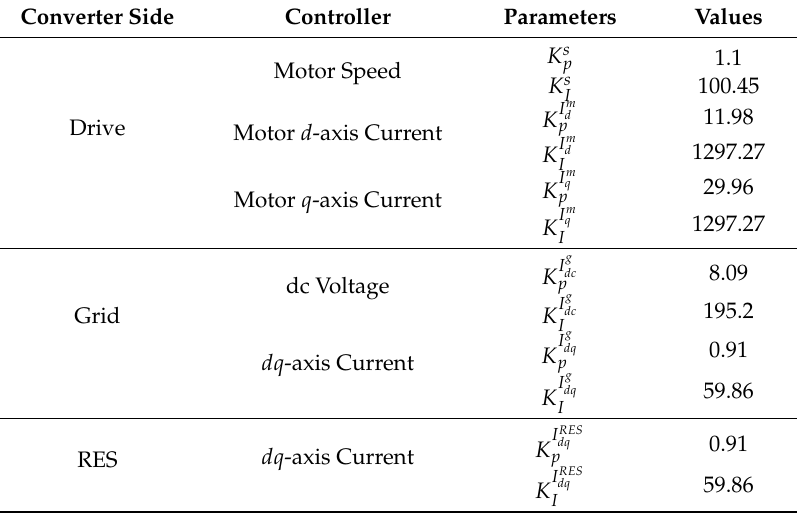
Figure 9. The response of the ( a ) DC link voltage, active powers for ( b ) RES1, ( c ) RES2, and ( d ) grid-side. Table 1. Optimization